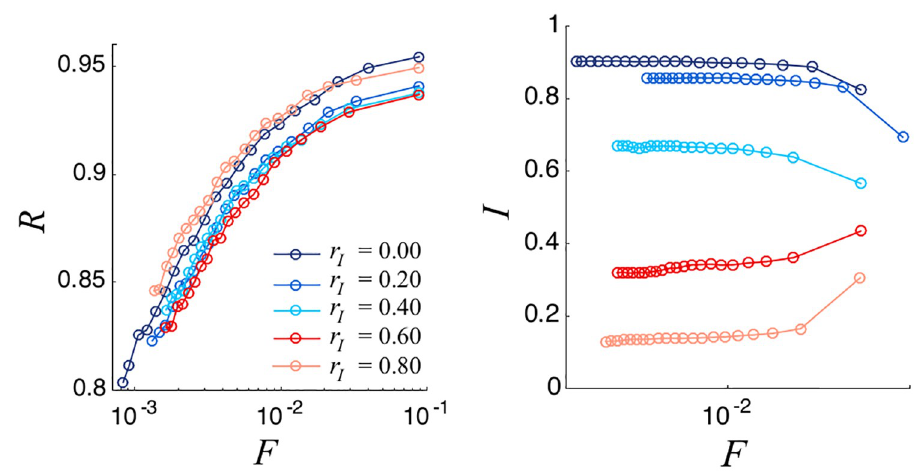
Fig 8. Representativity versus normalized committee size (left), Mean Committee integrity as a function of normalized committee size (right) for different values of p (the percentage of individuals with a distorted integrity perception). We consider a Erdo¨s-Re´nyi network with N averaged over 100 different